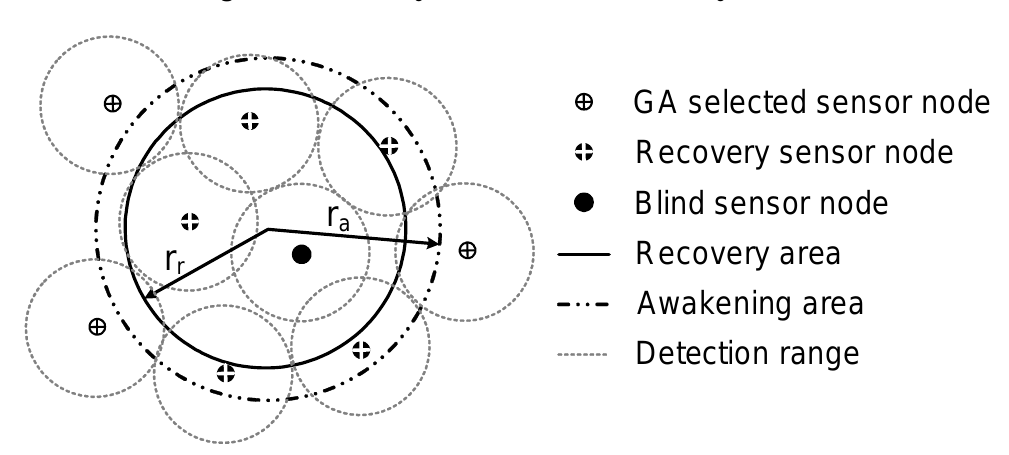
Figure 5 . Recovery sensor nodes selected by